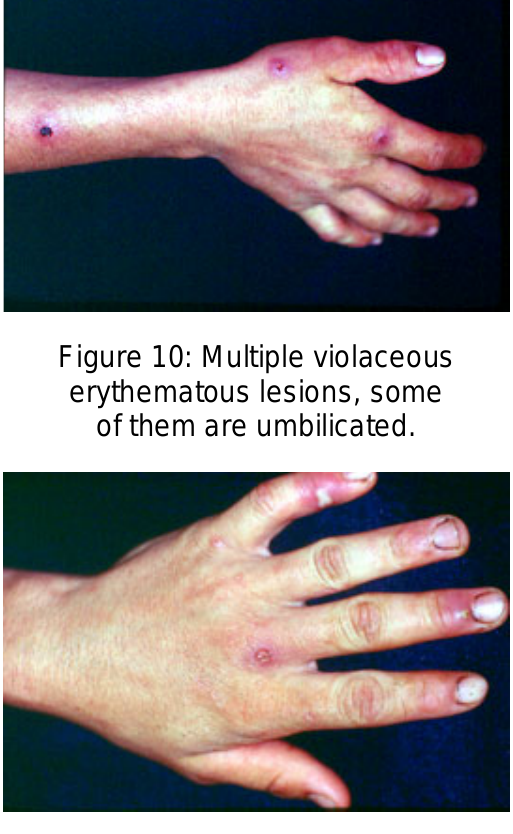
Figure 12: Presence of important erythema and pustular lesion in the fifth